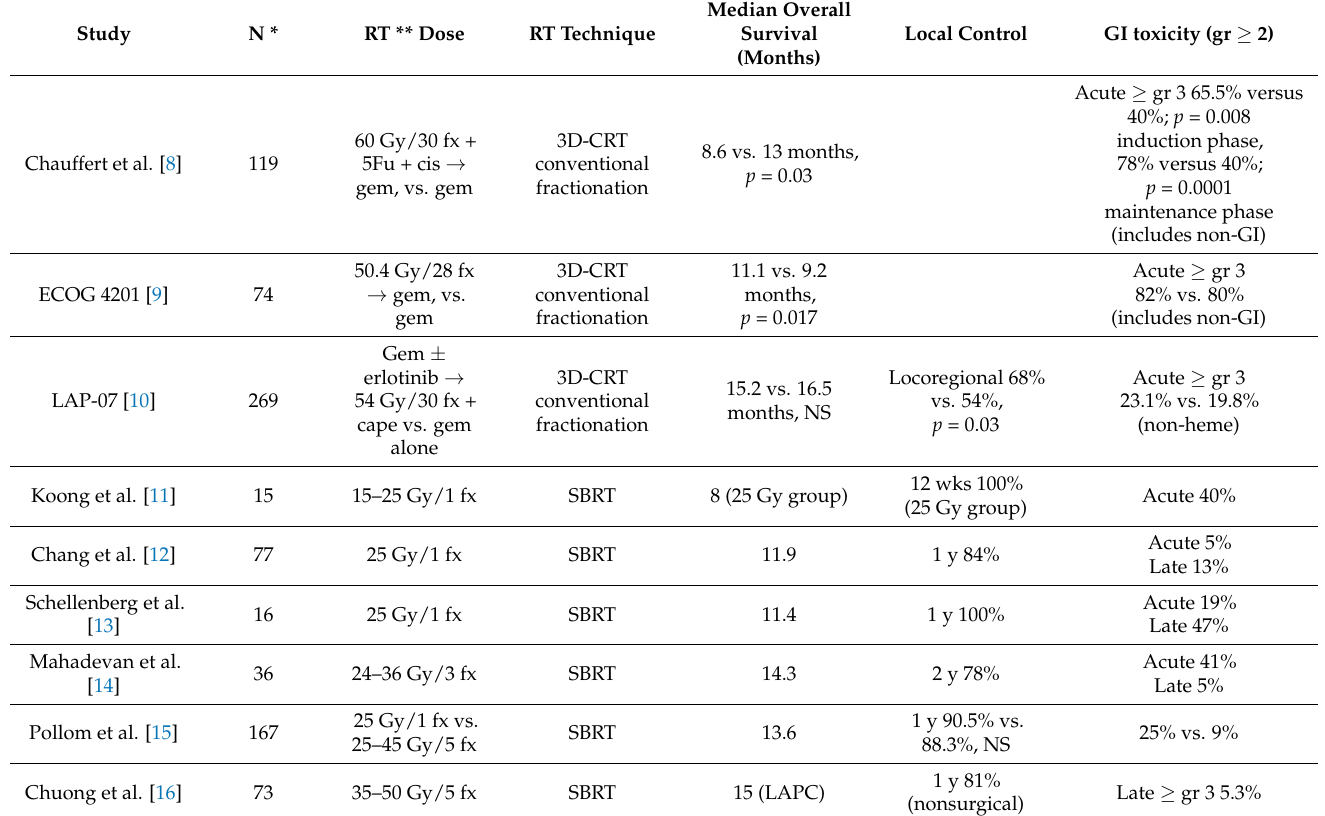
Table 1. Representative Modern Pancreas Cancer Radiotherapy